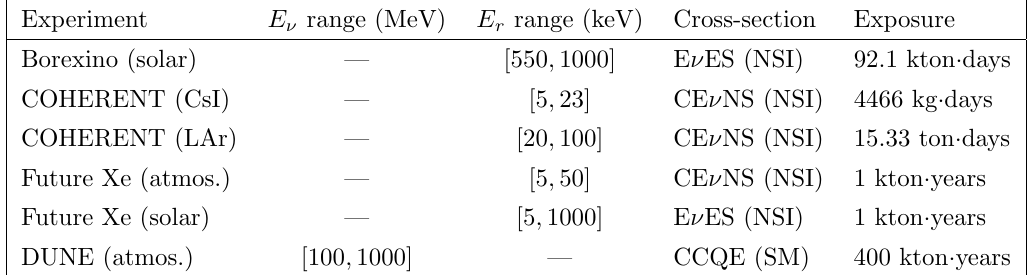
Table 2 . Kinematic con(cid:12)gurations and exposures for each experiment